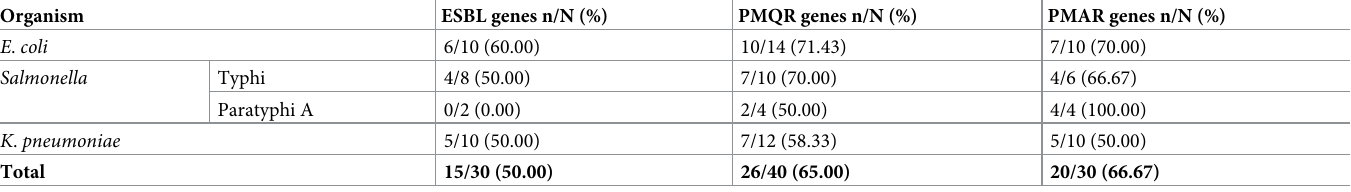
Where N = total number of isolates tested, n = number of isolates positive for given